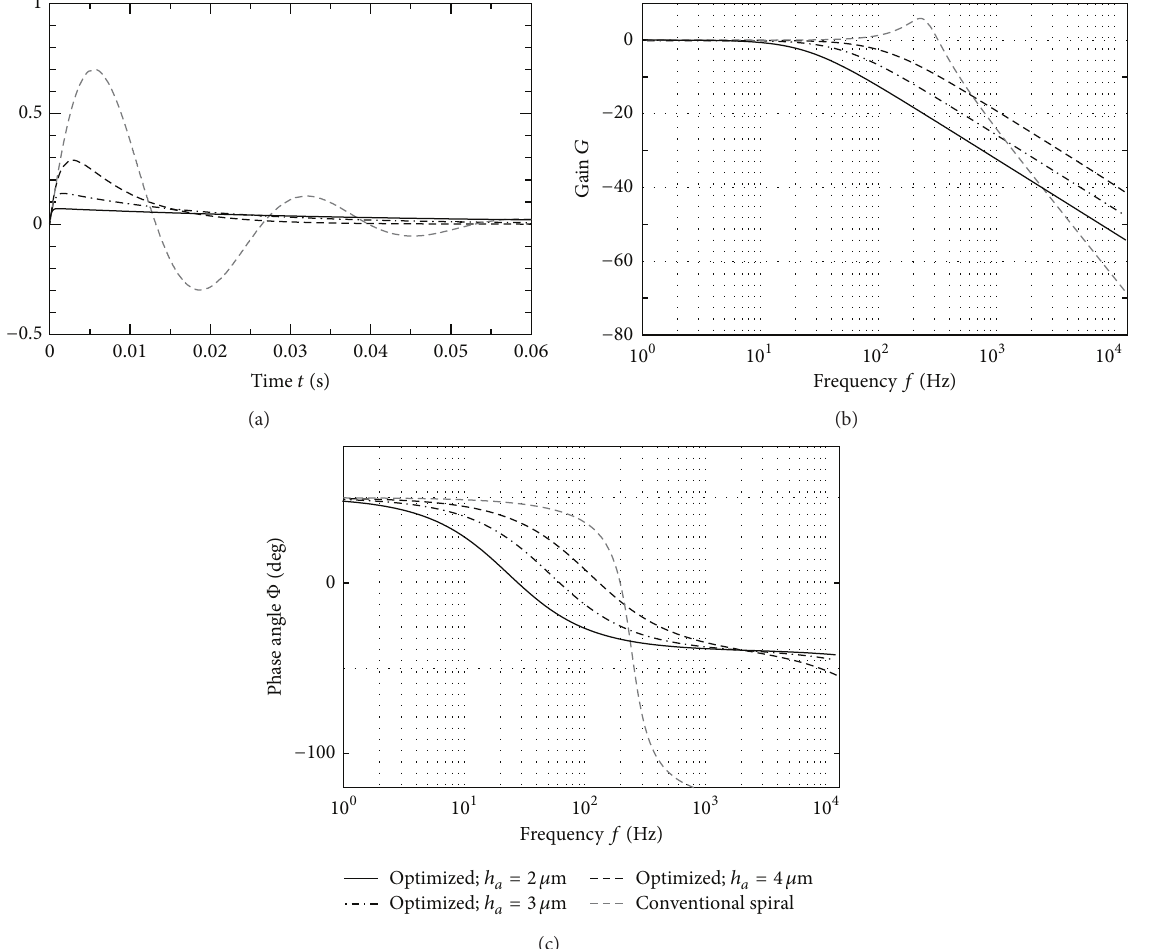
Figure 7: Vibration characteristics of optimized at 10,000rpm bearings and conventional spiral bearing; (a) displacement with impulsive force, (b) gain versus frequency, and (c) phase angle versus